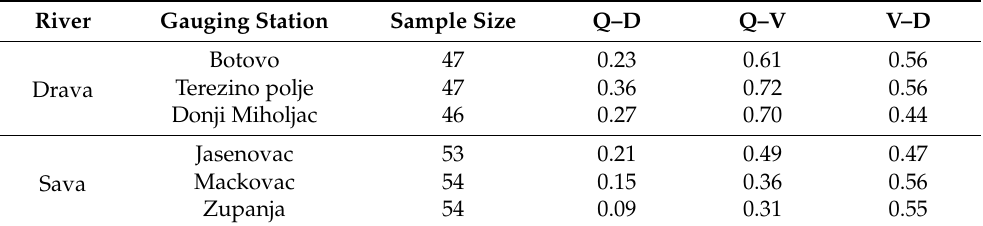
Table 8. Kendall correlation coefficient values for pairs of analyzed flood